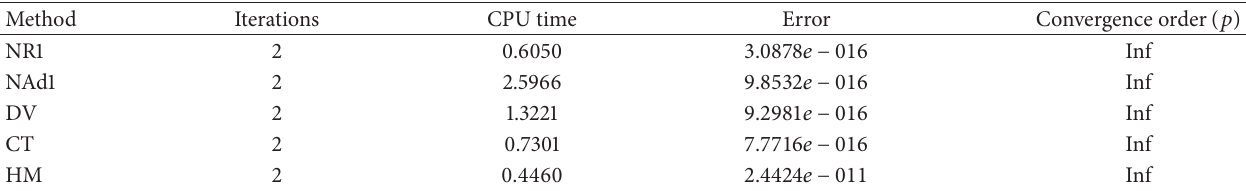
Table 9: Numerical results of Example 7 for dimensions 𝑛 = 1024